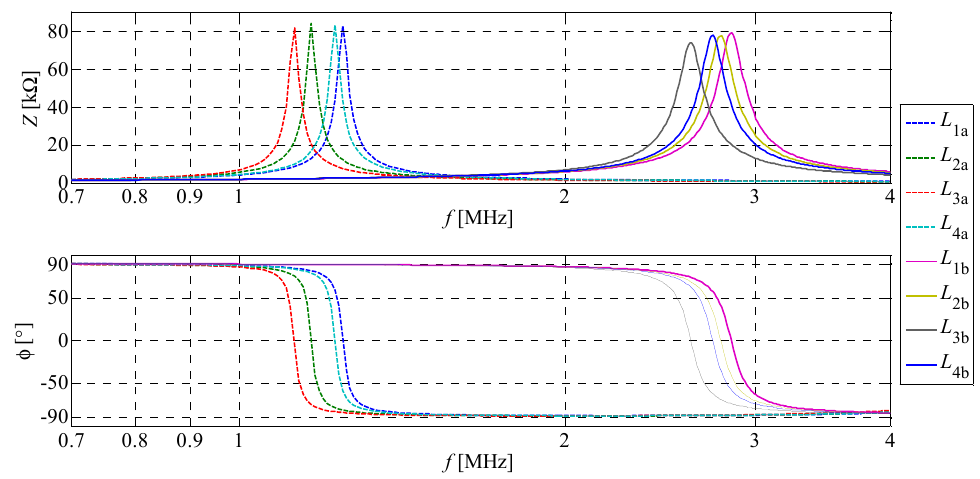
Figure 6. Impedance characteristics of two sets of four inductors.